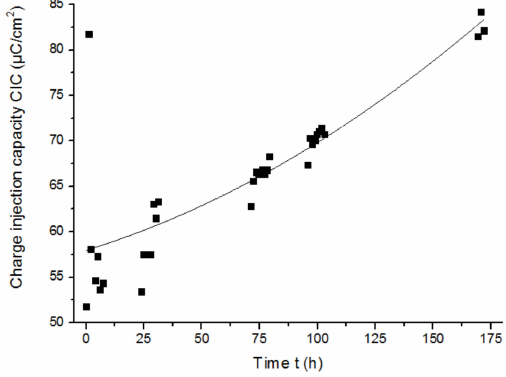
Figure 16. CIC of the Pt cu ff electrode G over time.